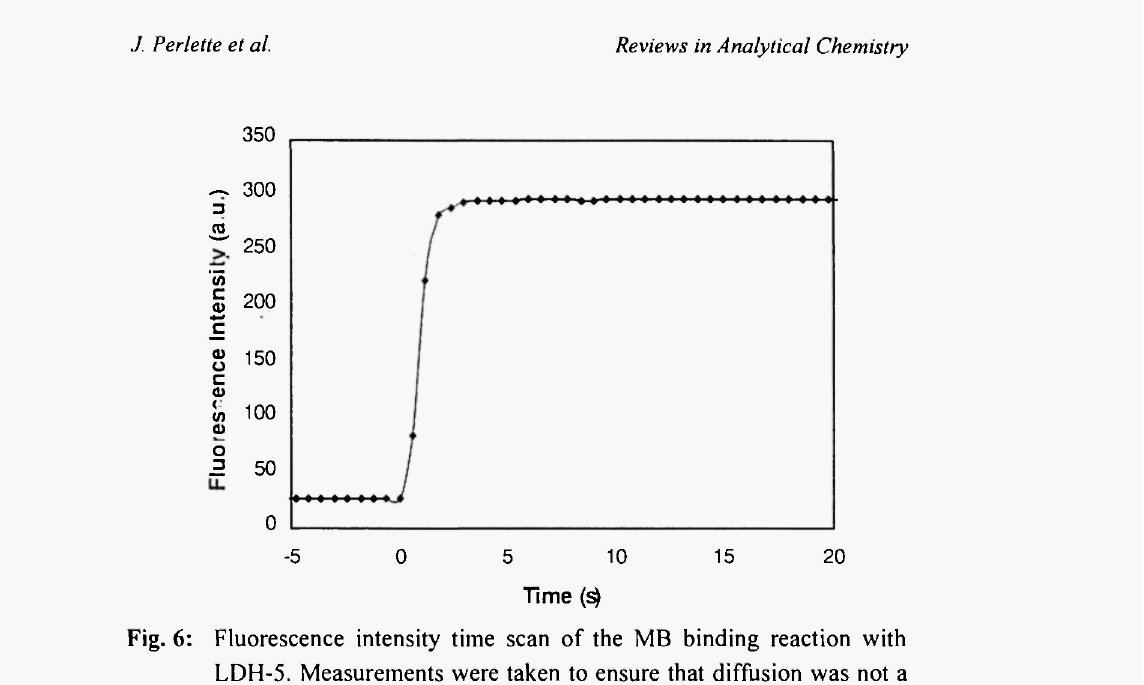
Fig. 6: Fluorescence intensity time scan of the MB binding reaction with LDH-5. Measurements were taken to ensure that diffusion was not a factor in the reaction rate (15 seconds were used to fully mix MB and LDH-5 solution before the measurement). The concentrations of MB and LDH were 0.5 μΜ and 1 μΜ. The buffer used was 20 mM Tris-HCl, 0.05 mM MgCl 2 , pH = 7.8. Reprinted from reference 17 with